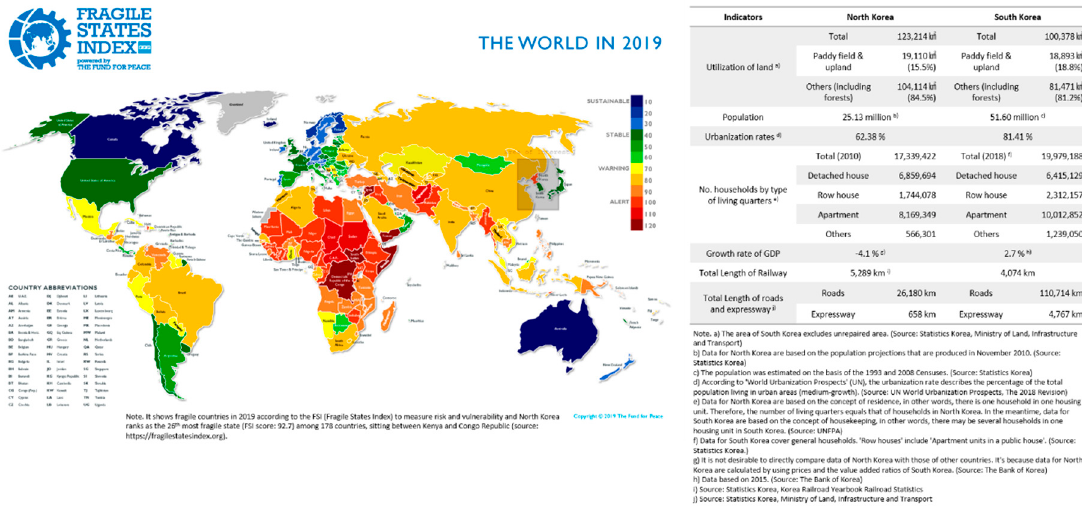
Figure 1. Contextualization of Area of Interest (left: Fragile States Index 2019 (https://fragilestatesindex.org), right: background information of South and North Korea based on Major Statistics Indicators of North Korea 2019 (https://kosis.kr/bukhan/index/index.do) (devised by authors).